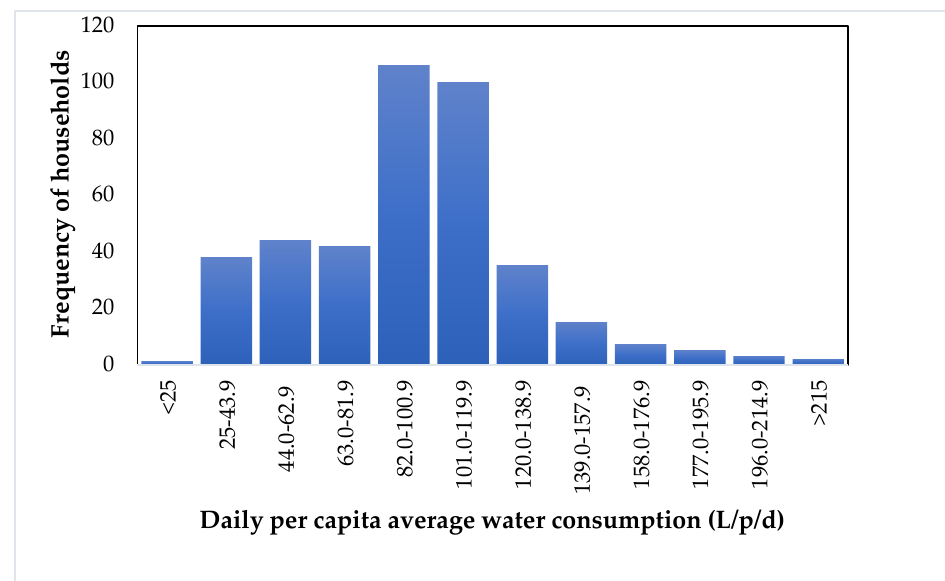
Figure 5. Frequency distribution of average per capita water consumption.